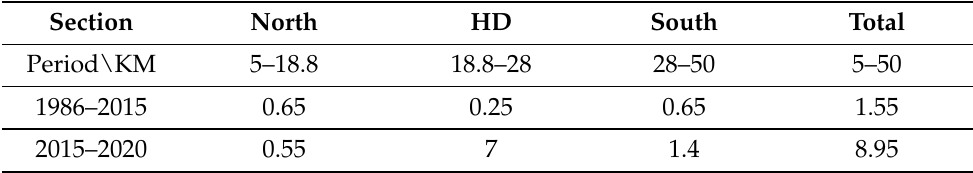
Table 1. Total nourishment volumes [ × 10 6 m 3 /y] at the NH coast